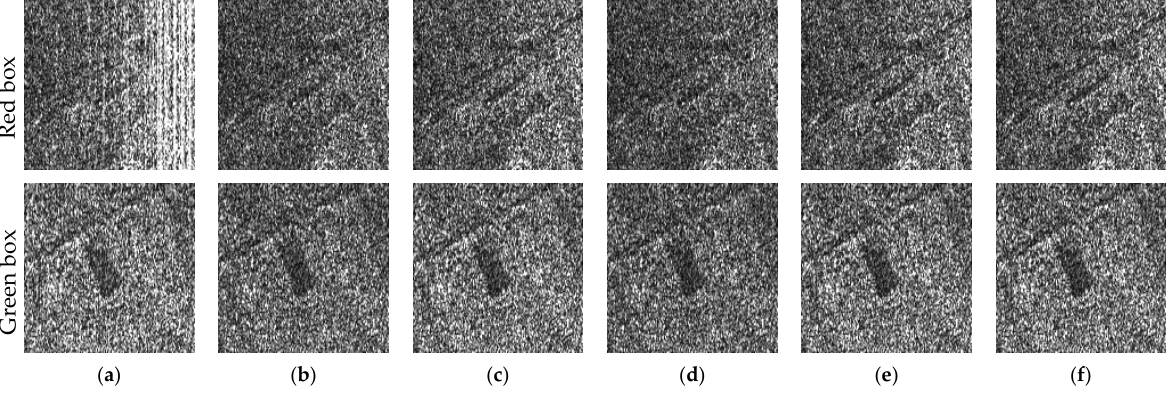
Figure 18. Comparison of the enlarged areas in Figure 17. (Row 1): the red box region; (Row 2) the green box region. ( a ) The RFI-free SAR image, ( b ) ISNF, ( c ) ESP, ( d ) GoDec, ( e ) LRDS, and ( f ) TFC-LRS. Table 7. Performance comparison of RFI mitigation algorithms for the measured NBI-corrupted SAR